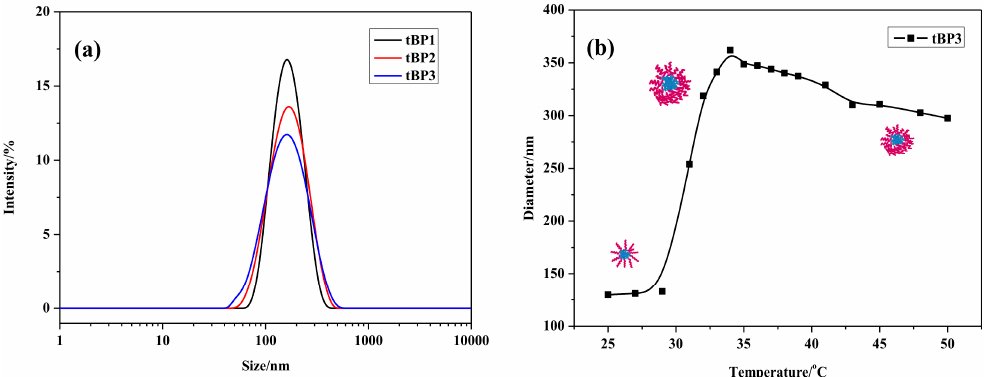
Figure 4. Size distributions of tBPs aqueous solutions (2 mg·mL − 1 ) ( a ) and the evolution of the diameters of the nanoparticles of the tBP3 versus temperature (2 mg·mL − 1 ) ( b ).